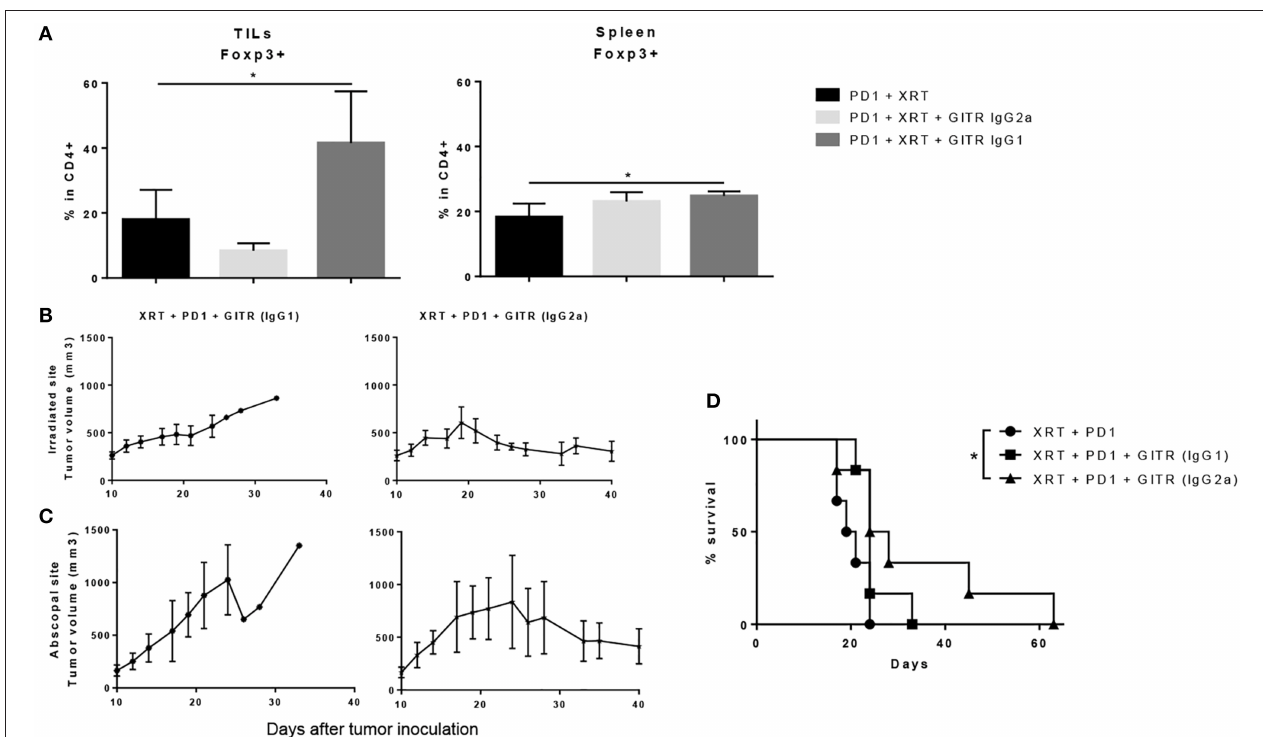
FIGURE 6 | Anti-GITR IgG2a depletes Tregs at the tumor site and promotes abscopal effects when combined with radiation and anti-PD1, while anti-GITR IgG1 expands Tregs and does not promote abscopal effects. (A) Flow cytometry percentages of CD4 + Foxp3 + T cells in gated lymphocytes isolated from tumors and spleens, 6 days post XRT. ( n = 6) (B) Primary and (C) secondary tumors were inoculated and XRT was delivered 10 days post tumor inoculation ( n = 6). (D) Survival was monitored out to day 63 ( n = 6). * P ≤ 0.05 in Student t -tests.